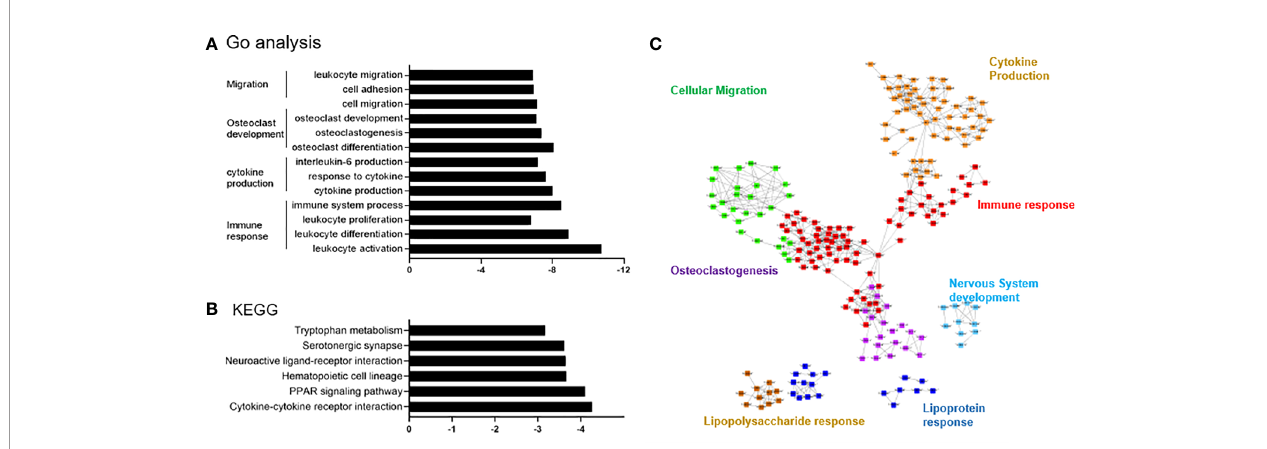
FIGURE 2 | Differential expression and pathway enrichment analyses. (A) Functional enrichment analysis for the differentially expressed genes (DEGs) in pigmented villonodular synovitis (PVNS) sample compared to osteoarthritis (OA) control sample. (B) Kyoto Encyclopedia of Genes and Genomes pathway enrichment analysis demonstrating the DEGs in PVNS compared to OA. (C) Cytoscape plot to re fl ect the relationships of the Gene Ontology